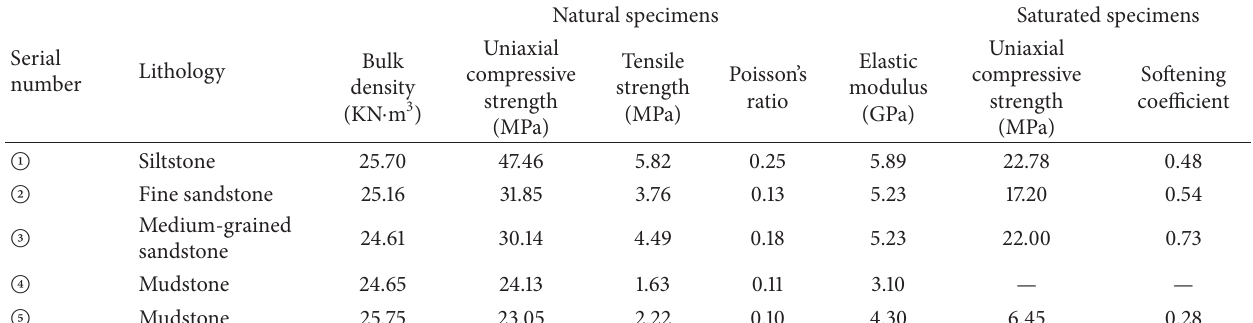
Table 2: Physical and mechanical parameters of surrounding rocks.